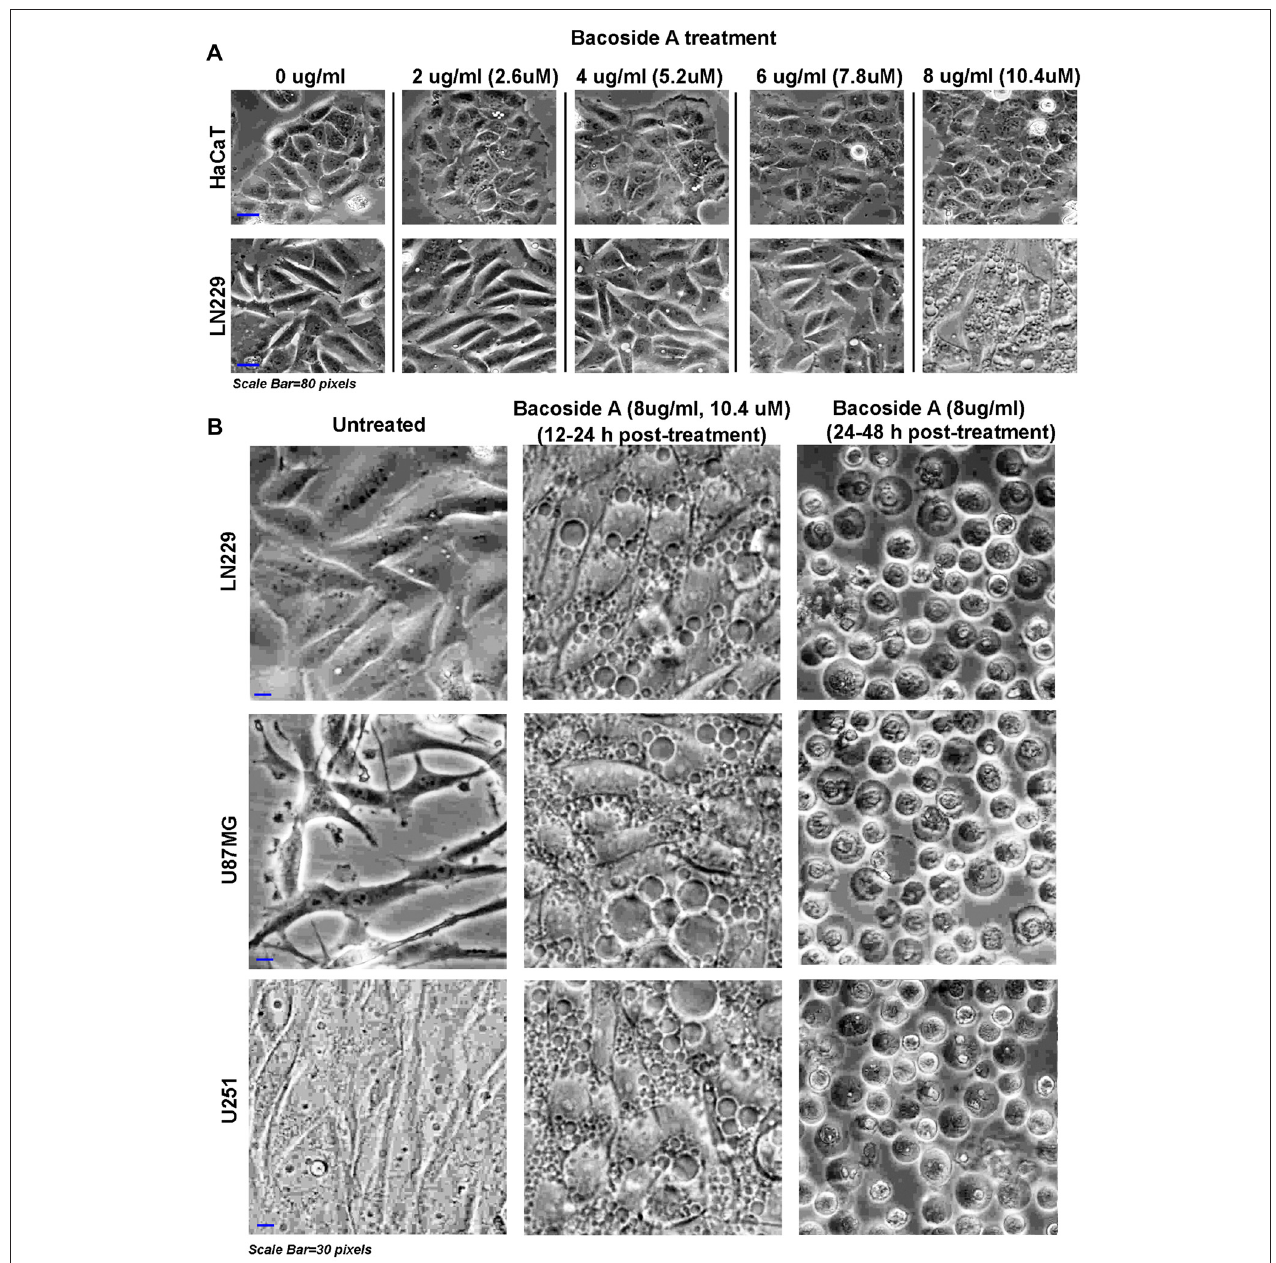
FIGURE 7 | Dose response of Bacoside A demonstrates extensive vacuolization resulting in cell swelling and glioblastoma tumor cell death. (A) shows phase contrast images of confluent cultures of HaCaT (normal control cells) and LN229 glioblastoma cell line that were treated with varying doses of Bacoside A for 12 h. A dose of 8 µ g/ml and above showed appearance of cytoplasmic vacuoles only in tumor cells and these vacuoles progressively fused with time to occupy the entire cellular space. (B) Different glioblastoma cell lines were used to confirm the consistency of Bacoside A vacuolization induced cytotoxic effects at a dose of 8 µ g/ml at various time points. Bacoside A treatments produced phase lucent vacuoles, characteristic of macropinosomes, that progressively occupied the entire space, and caused cellular hypertrophy by 12–24 h of treatment ( B , middle panel) and beyond this time period, the cells were seen to transform into fluid filled, swelled, rounded structures with squashed intracellular organelles and nuclei and many showed necrotic phenotypes ( B , last panel). At least five random fields per time point were imaged and analyzed. The images are representative of five independent experiments.